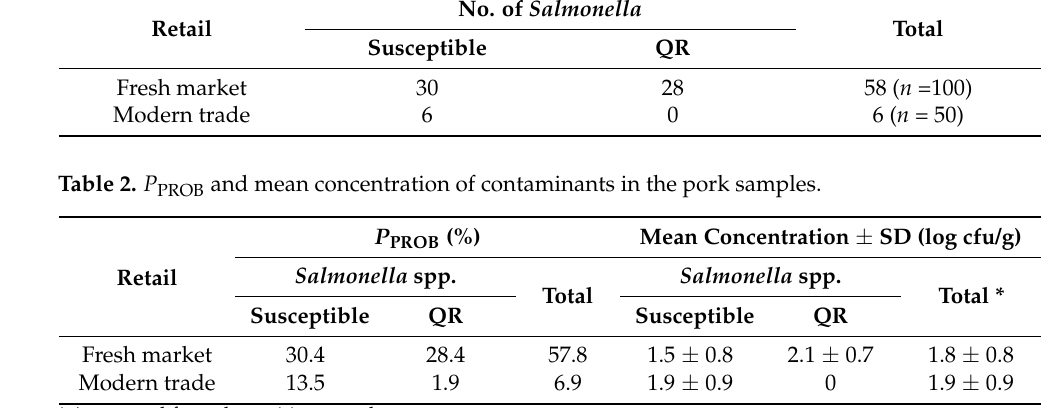
Table 1. No. of Salmonella positive samples collected from retailers in Chiang Mai province.